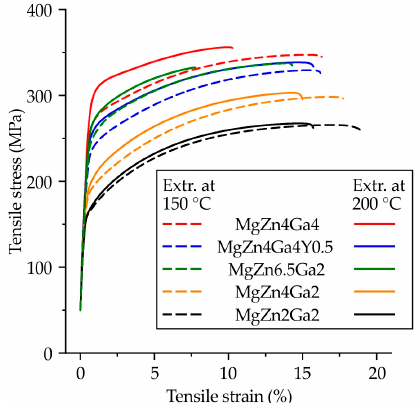
Figure 9. XRD patterns of ( a ) MgZn4Ga4, ( b ) MgZn4Ga4Y0.5, ( c ) MgZn6.5Ga2, ( d ) MgZn4Ga2, ( e ) MgZn2Ga2 after hot extrusion at 150 °C.